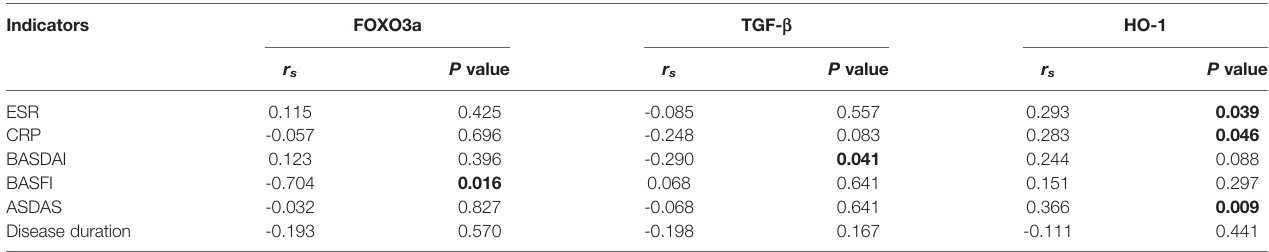
TABLE 2 | Correlation between FOXO3a, TGF- b , HO-1 and clinical indicators of AS patients. Indicators FOXO3a TGF- b HO-1 r s P value r s P value r s P value ESR